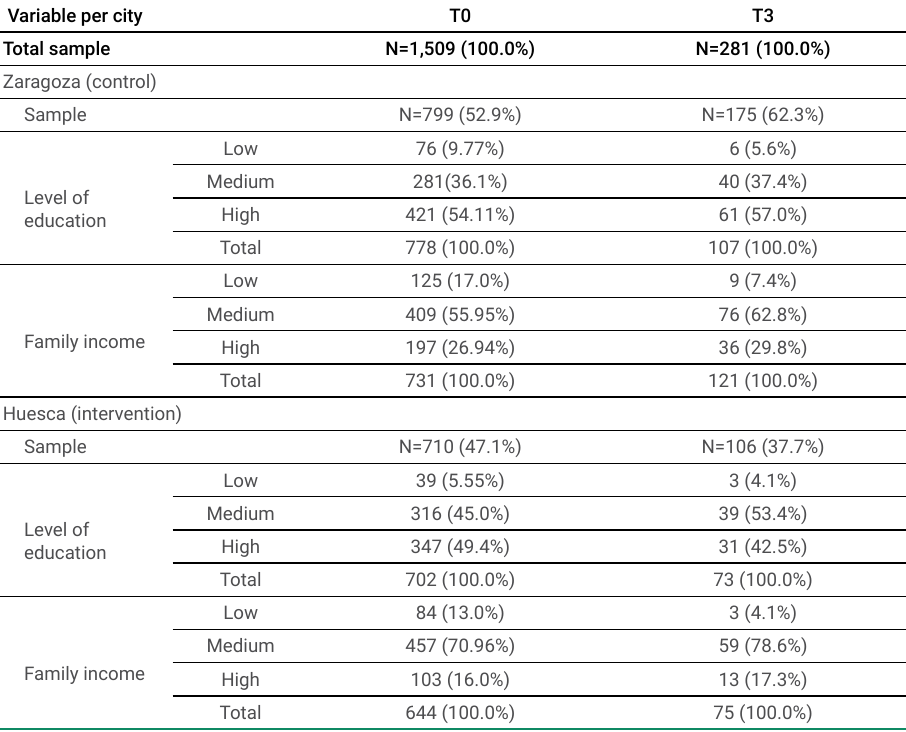
Table 1. Socioeconomic data of the total sample at T0 (2007) and of the sample of 7 to 11-year-olds at T3 (2013), per Spanish city. Variable per city